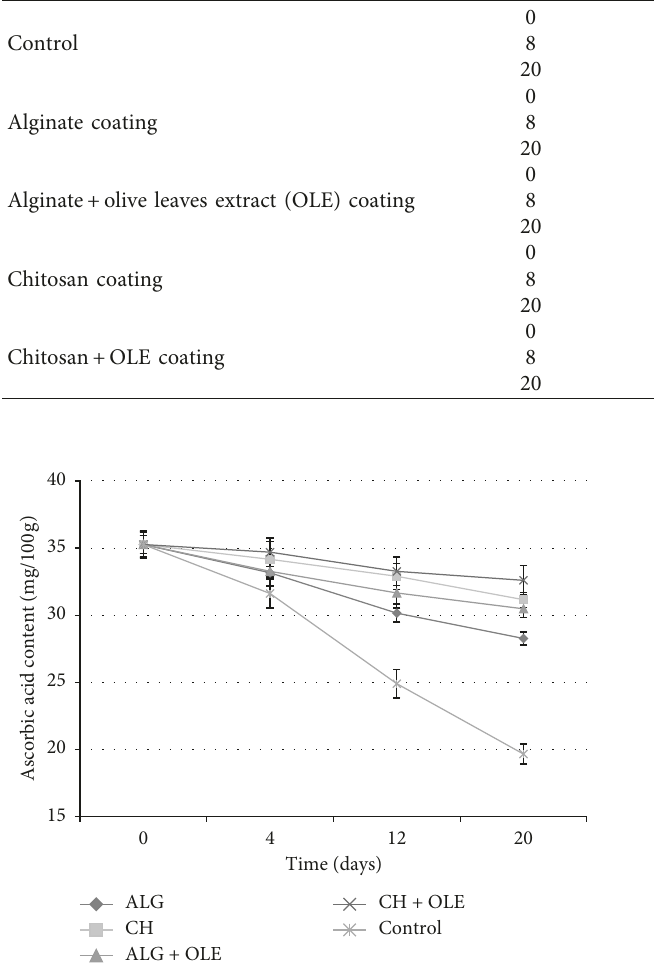
Table 1: Total soluble solids and titratable acidity of uncoated and coated fruits after 20 days of storage. Days